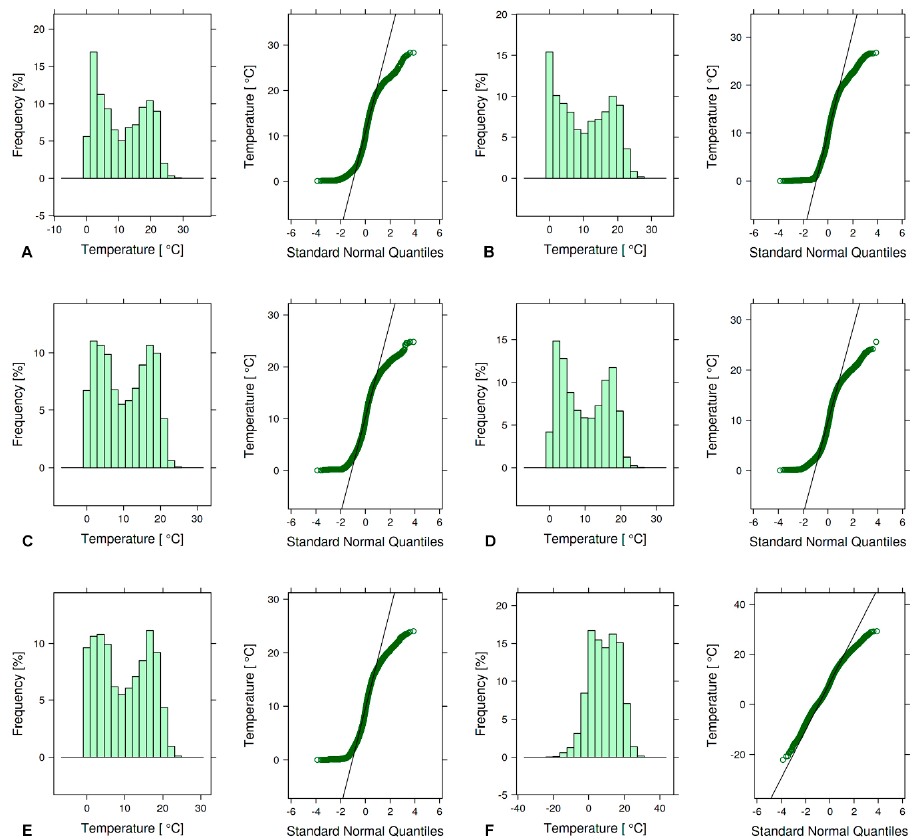
Figure 2. Frequency histograms and quantile plots of the distribution of daily water temperature series for the Note ć and its tributaries, and of air temperature (1987–2013): ( A ) Note ć –Pako ść , ( B )